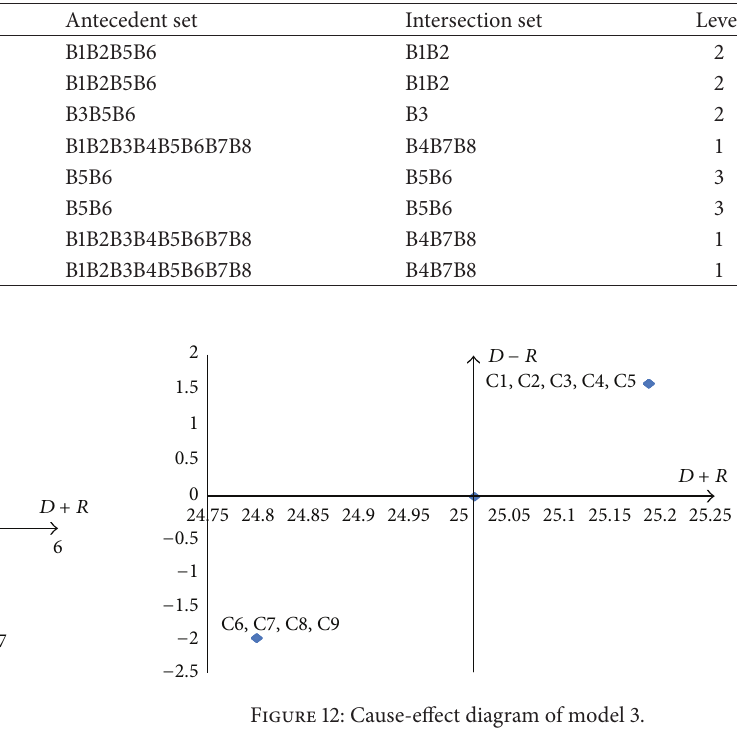
Figure 12: Cause-effect diagram of model 3.